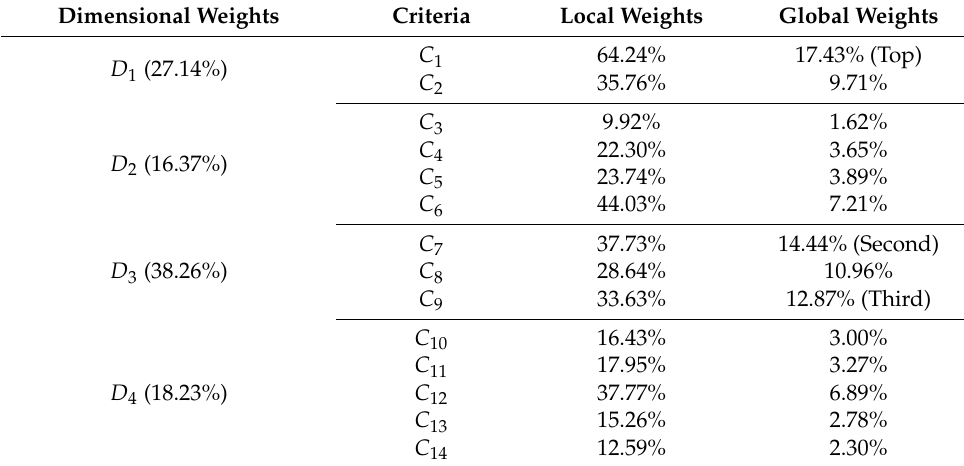
Table 5. BWM model’s local and global weights.